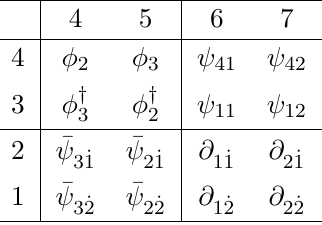
Table 2 . Single excitations of the full N = 4 SYM spin chain in the \Beauty" grading. The table